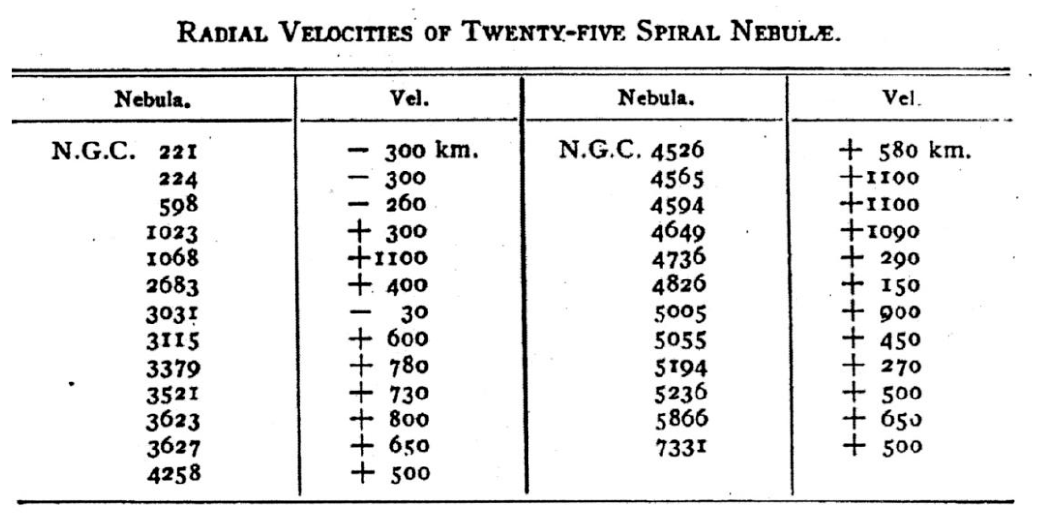
Figure 3. The radial velocities of 25 spiral nebulae published by Slipher [32] in 1917. Minus means motion towards us and plus away. The velocities are given in km/s. (See also O’Raifeartaigh [33]).